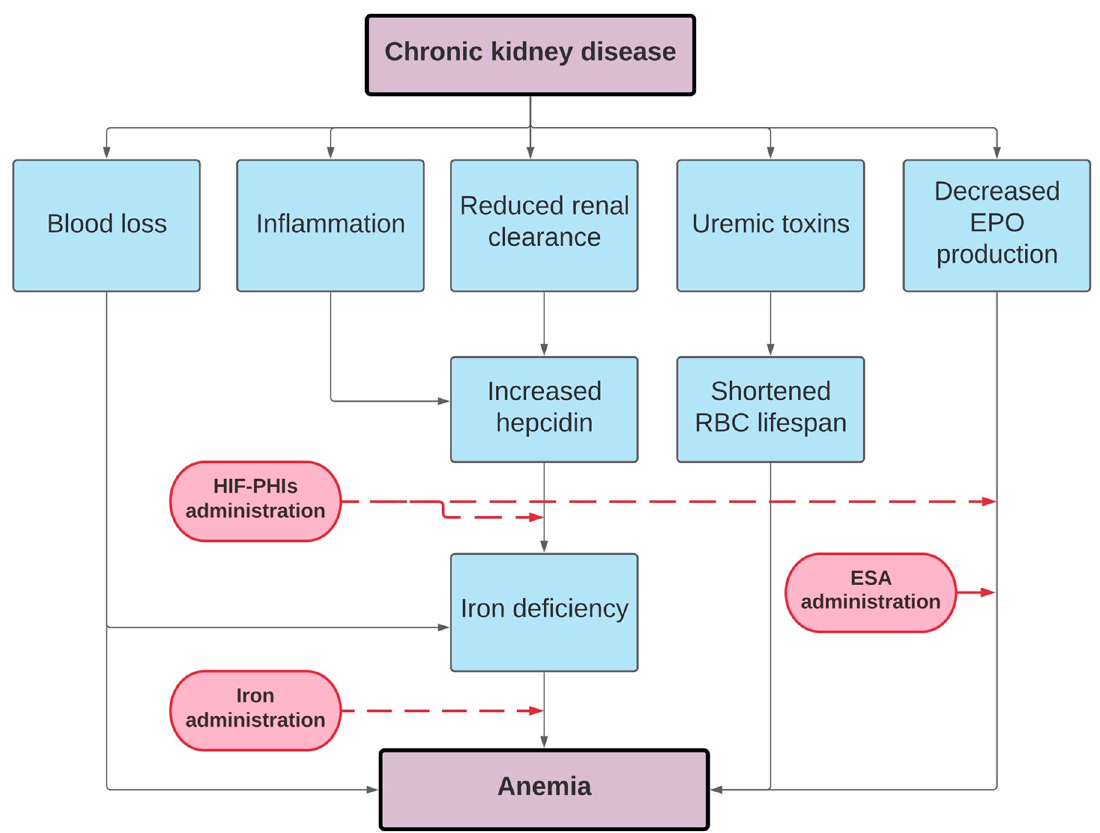
Figure 2. Pathophysiology of renal anemia and treatment options.